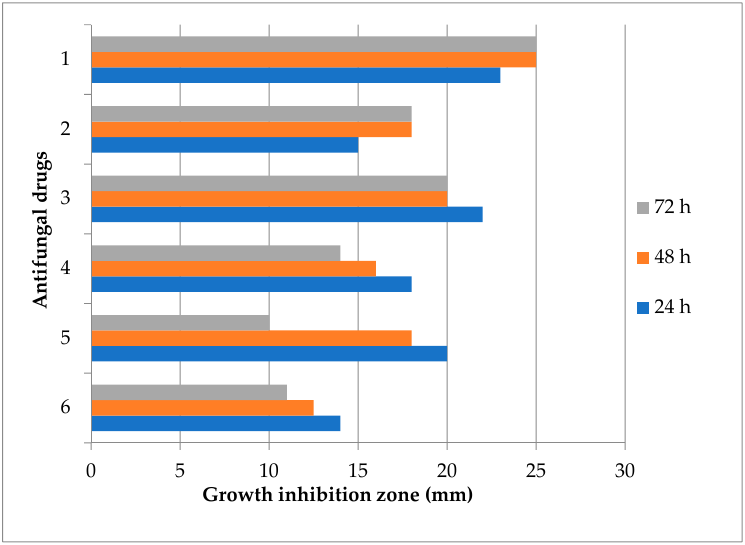
Figure 3. Analysis of the sensitivity of drugs to the causative agent of C. parapsilosis : (1) Ketoconazole, 20 mcg; (2) Itraconazole, 10 mg; (3) Fluconazole, 40 mcg; (4) Clotrimazole, 10 mcg; (5) Nystatin, 80 units; (6) Amphotericin B, 40 mg.